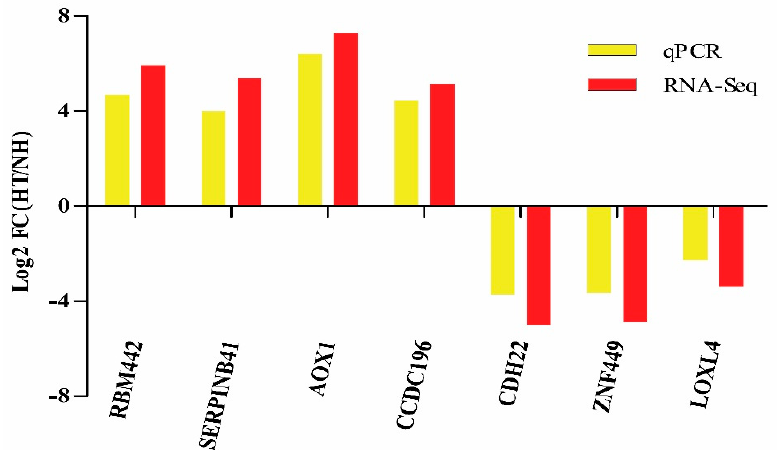
Figure 5. Validation of RNA-Seq results by qPCR. Bars of RNA-Seq and qPCR data were colored by black and white, respectively.